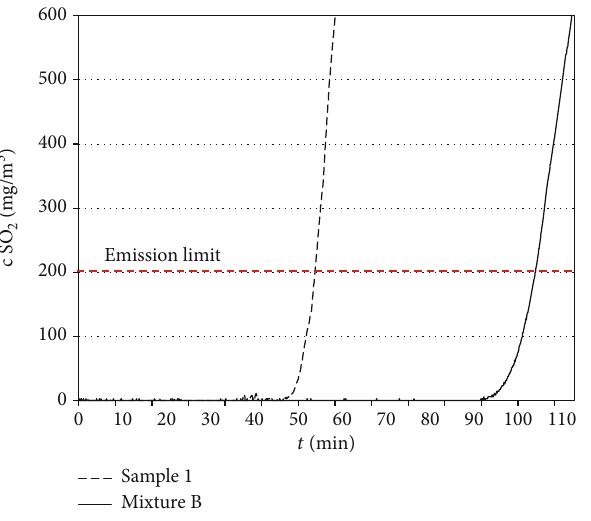
Figure 7: Comparison of mixture B with sample 1.